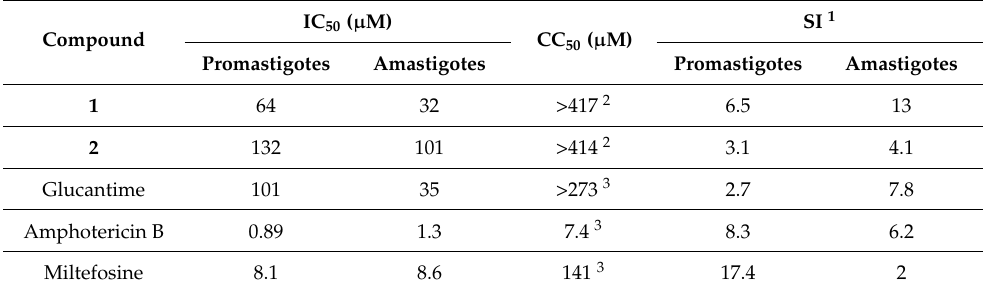
Table 2. Leishmanicidal activities, cytotoxicity and selective index of compounds 1 , 2 and reference